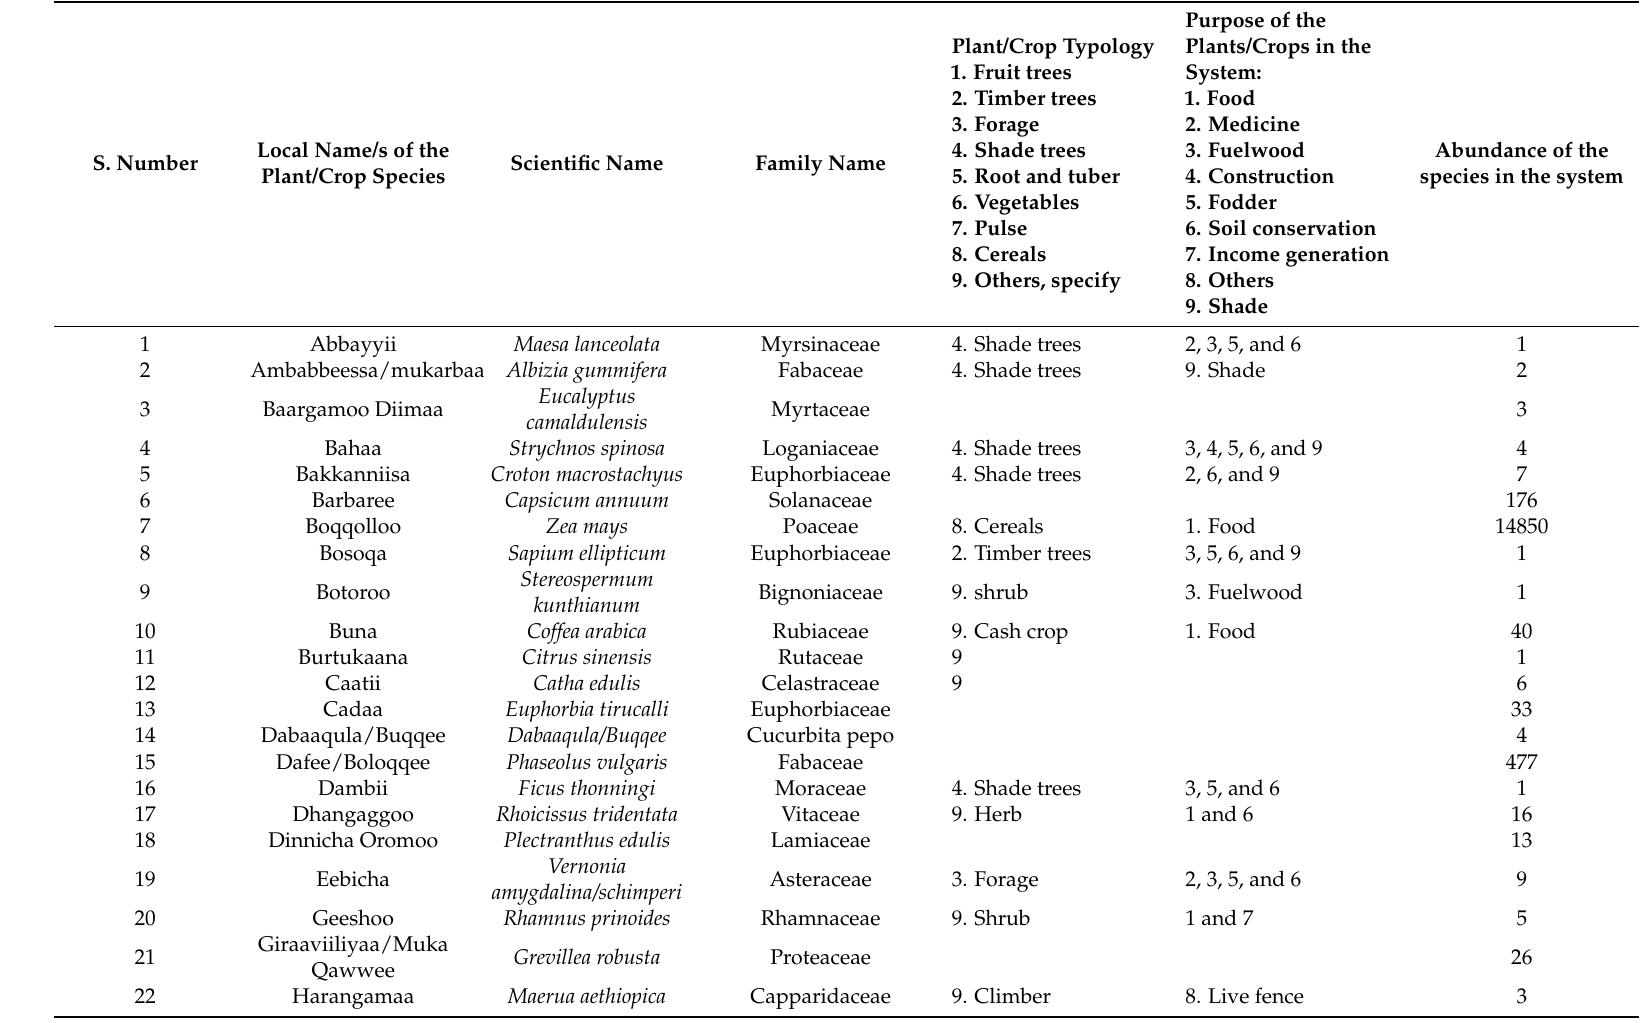
Table A5. Species Compositions of Annual Crop Production